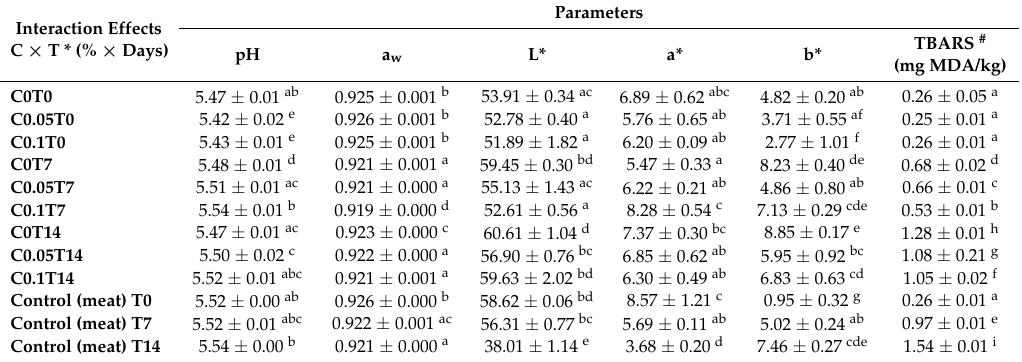
Table 1. Effect of cellulase addition and storage time on the physico-chemical parameters of coated